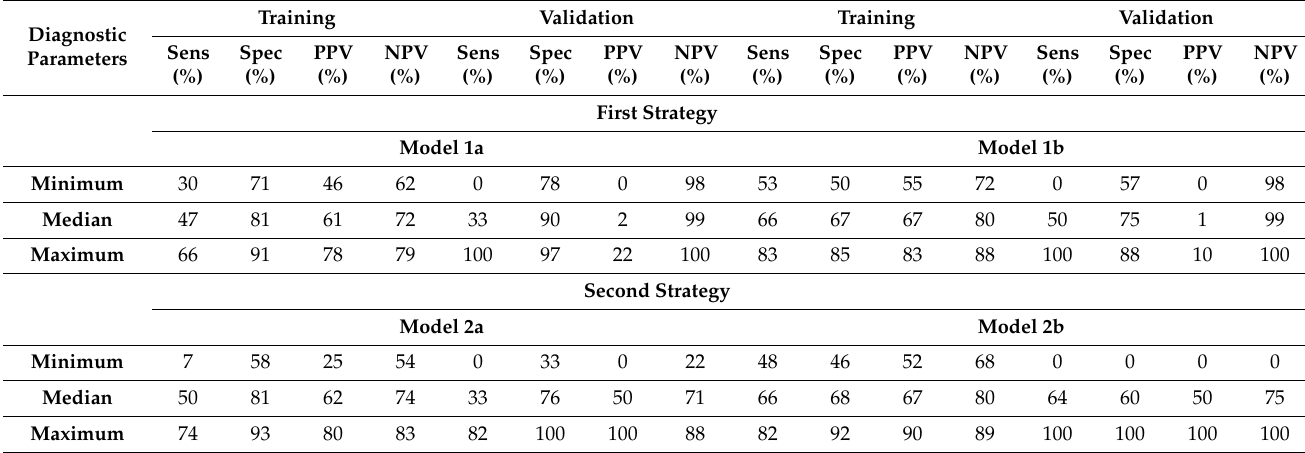
Table 2. The diagnostic performance of the radiomics models (100 iterations) for the first and second strategy. Diagnostic